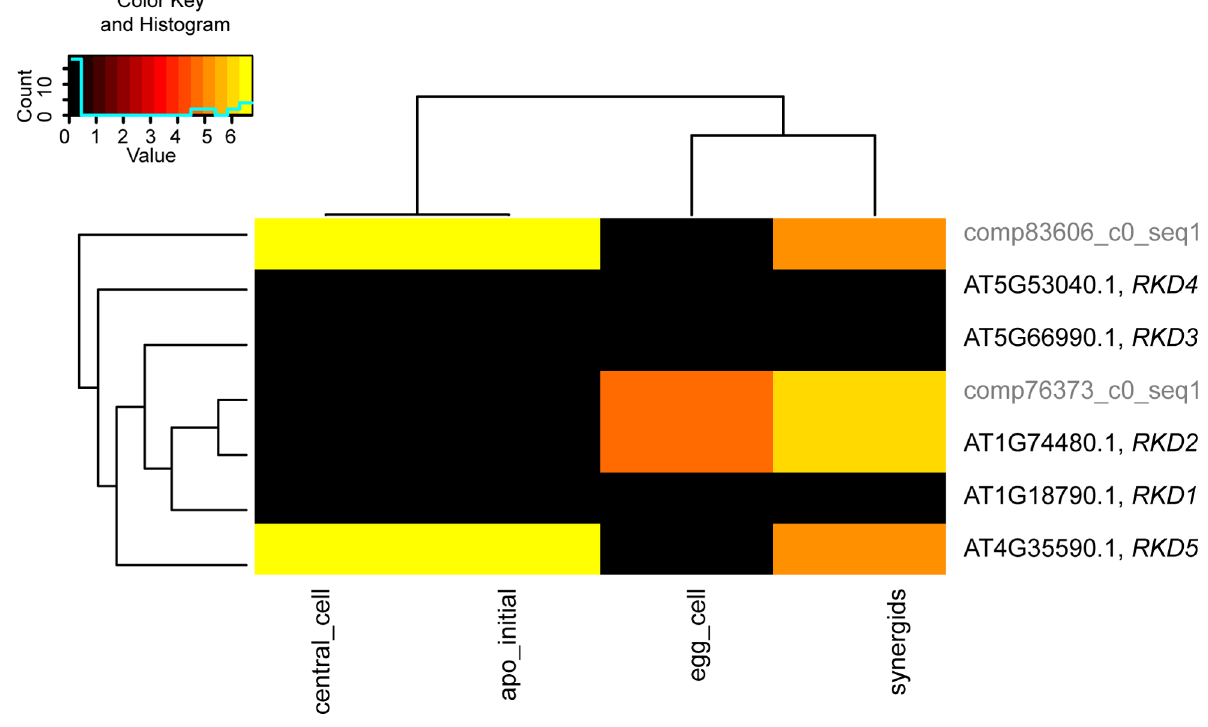
Figure 6. Analysis of sequence divergence of members of the AtRKD gene family. Analysis of sequence divergence of members of the AtRKD gene family and close Boechera homologues as analysed with ClustalX based on protein sequences and read counts assigned. Boechera gene model variants are indicated with compxxx_cY_seqZ.